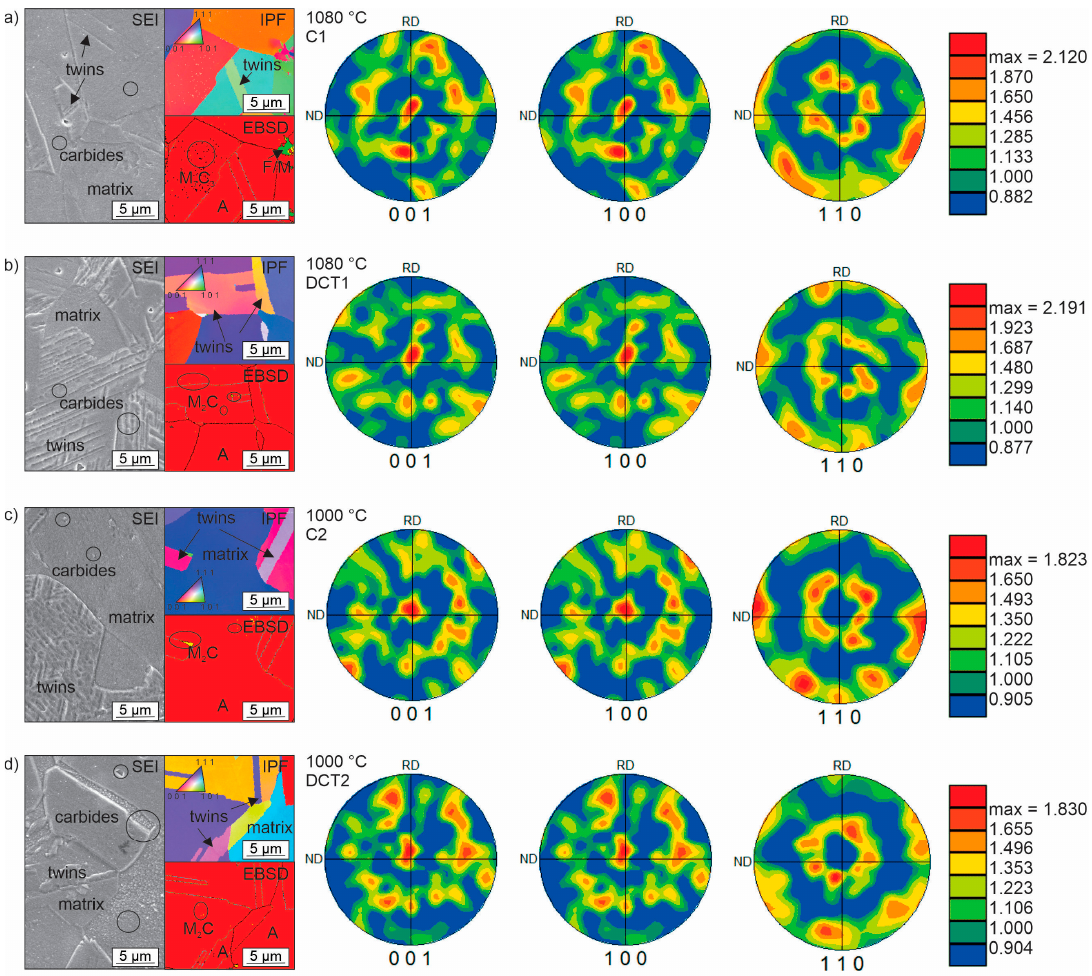
Figure 2. Microstructure obtained by SEM, EBSD, and pole figures of FCC (austenite) for all four subgroups of AISI 304 L. ( a , c ) are conventionally solution-annealed subgroups, where a is C1 and c is C2. ( b , d ) are deep cryogenically treated subgroups DCT1 and DCT2, where b is DCT1 and d is DCT2. The first two subgroups were treated with solution annealing at 1080 °C, and the second two subgroups were heat-treated at 1000 °C.